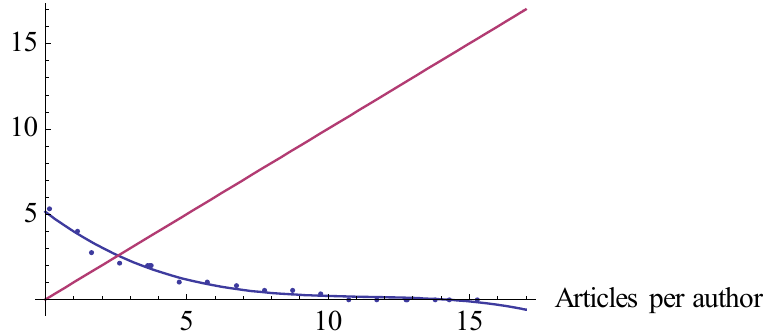
Figure 4. Least-squares cubic interpolation fitting for the H index per author per year (i.e., scientific core productivity): H cyn10 = 2.57 ( R 2 = 0.97; regression sum of squares = 40; sum of squares for the residuals = 1; F (4, 16) = 158 ( p < 0.001) with 4 parameters and 20 observations). The red increasing linear line represents y = x ; the blue decreasing line represents the fitted curve. Abbreviations: c = cubic interpolation; y = publications and citations per year, n = net citations; 10 = 10 years (2007 to 2016).